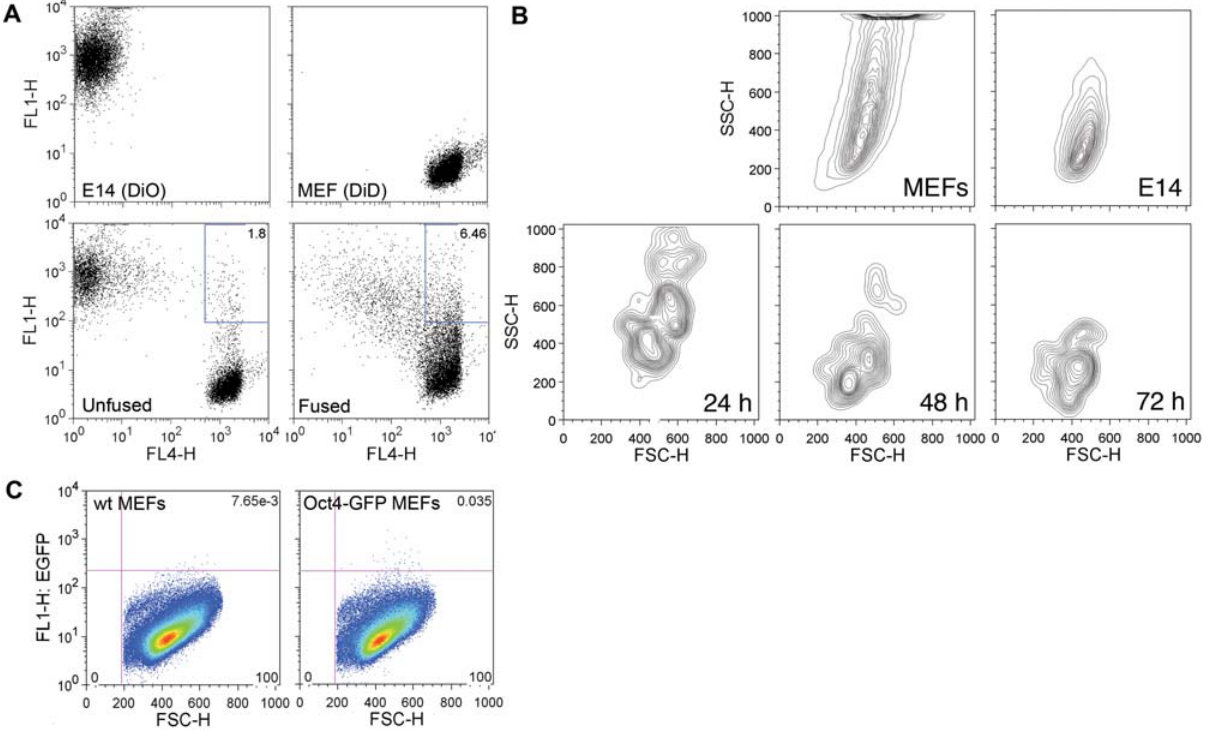
Figure 1. Establishment of an efficient fusion assay. A) Fusion efficiency of the assay. The MEFs and ESCs were stained with the fluorescent dyes Vybrant DiD and Vybrant DiO respectively before fusion. Fusion efficiency was determined by FACS analysis at 5 h post-fusion, using an unfused mixture of cells as a negative control. Note that previous studies have shown that cell surface dyes rarely diffuse across the cell membranes of stained cells [41]. The dual-labeled cells in the unfused population was most likely due to non-specific binding between the ESCs and MEFs. The green fluorescent dye Vybrant DiO was only used in the determination of fusion efficiency but not in a typical reprogramming experiment (due to interference with the observation of GFP signal). B) Morphology change of MEFs during reprogramming. The forward- and side-scatter profiles of the GFP positive cells were FACS analyzed at 24, 48 and 72 h post-fusion. The morphology of the reprogrammed MEFs changed with time to resemble that of the ESCs. C) Quantification of GFP expression. The number of GFP positive cells was FACS analyzed at 24 and 48 h post-fusion (right panel), using wildtype MEFs that did not carry the Oct4-gfp transgene but had undergone identical fusion treatment with ESCs as a negative control (left panel). The number of GFP positive cells from wt MEFs was subtracted from that of Oct4-gfp MEFs in all